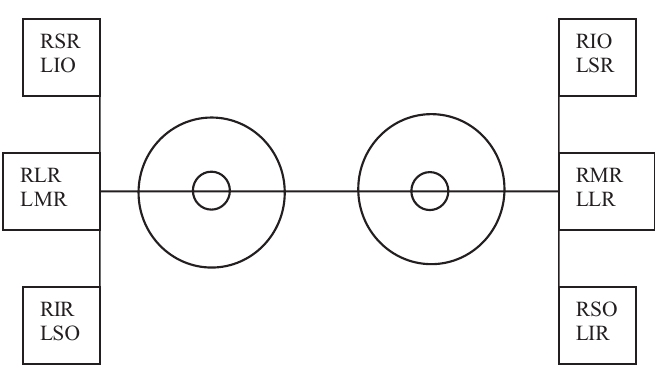
Figure 2: ‘H’ pattern of assessing pursuit eye